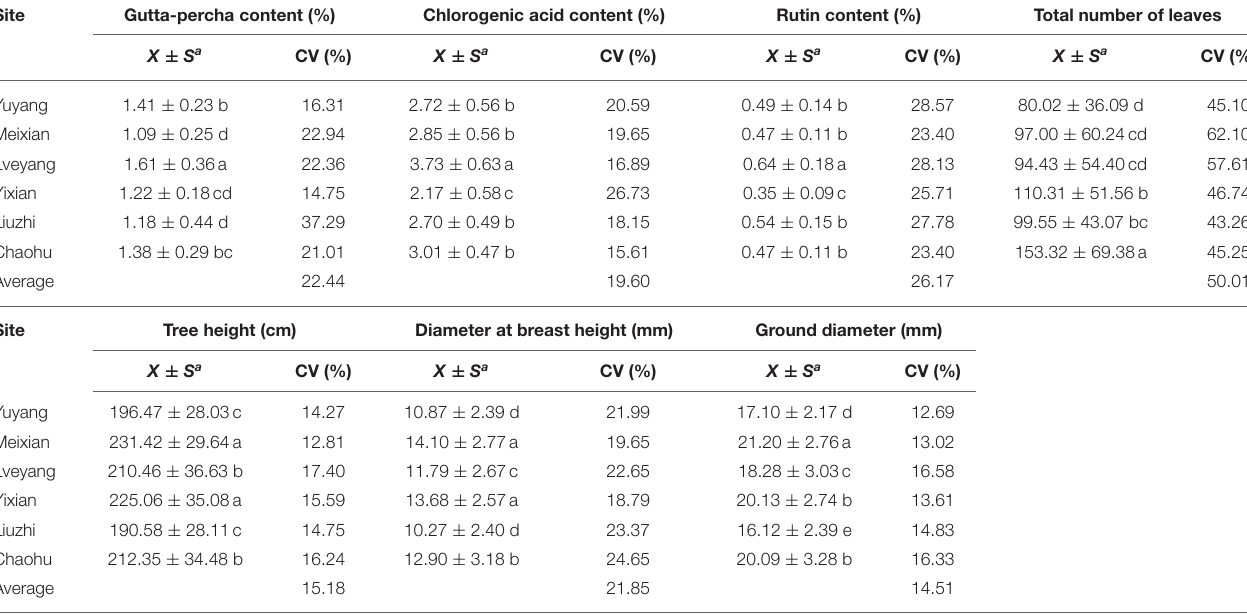
TABLE 6 | Multiple comparisons for traits among the experimental sites. Site